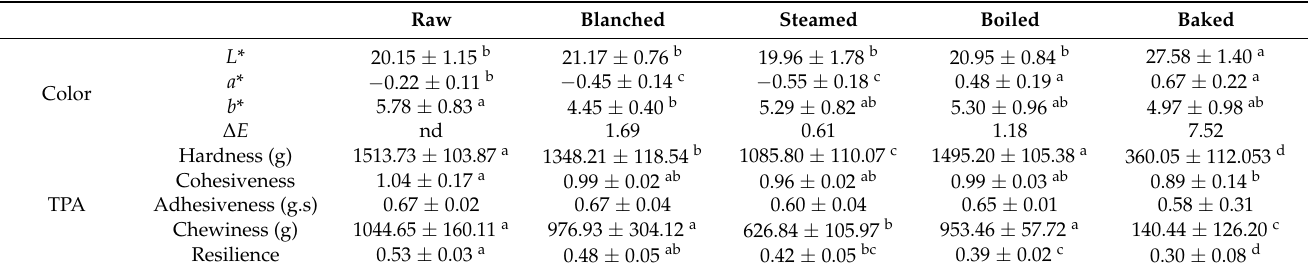
Figure 1. Raw and cooked L. japonica by different methods. The processing methods of L. japonica from left to right are ( a ) raw; ( b ) blanching; ( c ) steaming; ( d ) boiling; ( e ) baking. Table 1. Influence of different processing methods on the color and TPA of L. japonica .